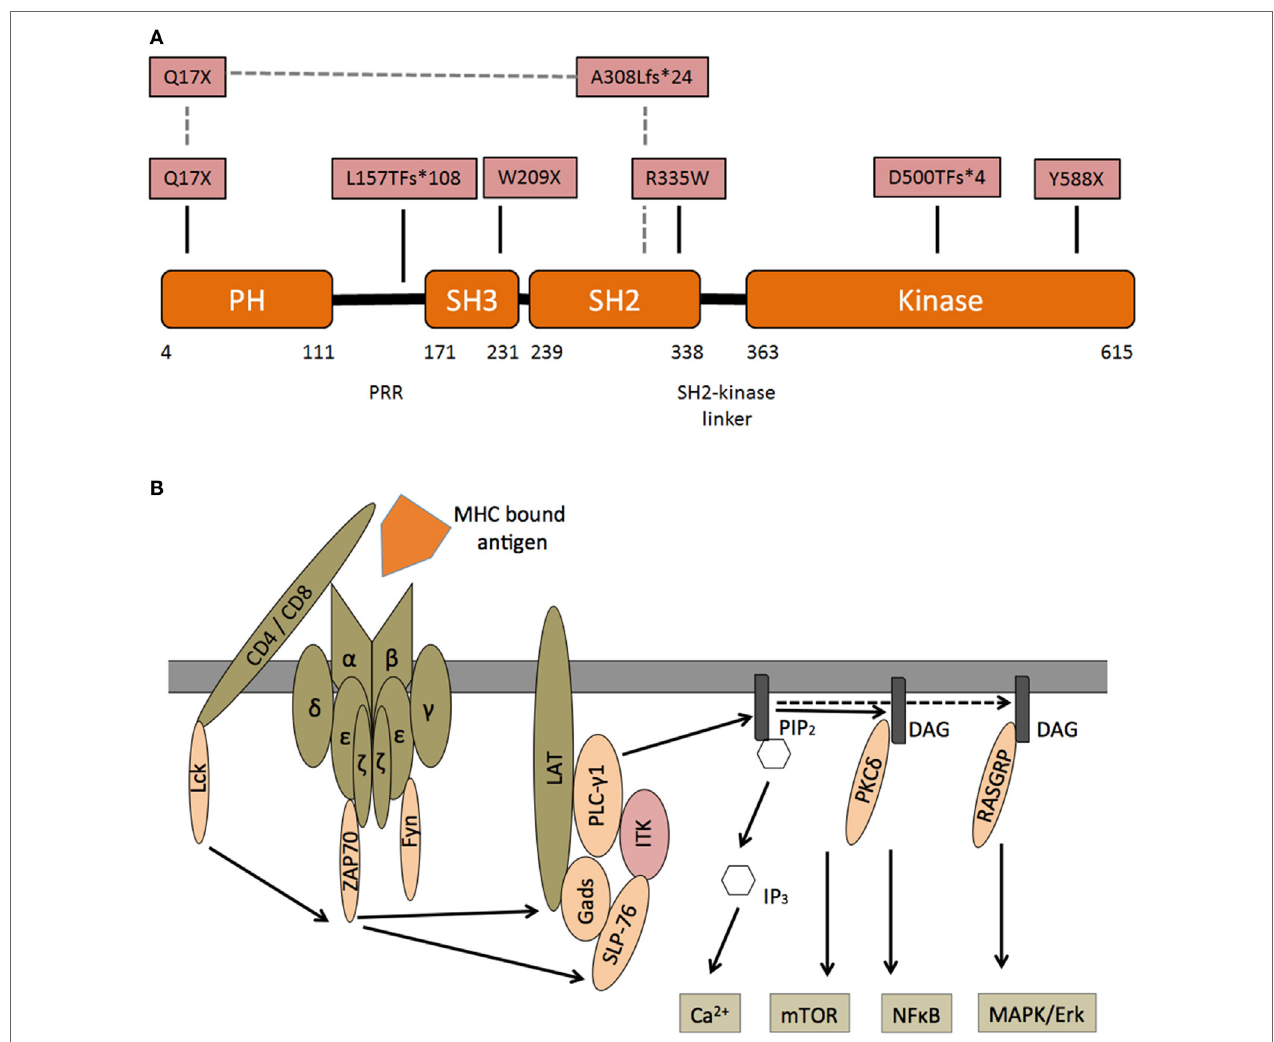
FiGUre 1 | Interleukin-2-inducible T-cell kinase (ITK)—structure and signaling— (A) domain organization of ITK and corresponding protein mutants in patients with ITK deficiency. N-terminal pleckstrin homology (PH), Tec homology, Src homology 3 (SH3), Src homology 2 (SH2), and C-terminal catalytic kinase domain. Pattern recognition receptors. In one patient, a compound heterozygous mutation is predicted to encode Q17X and A308LfS*24 mutant. (B) Following engagement of the T cell receptor (TCR) with an MHC bound foreign antigen, several intracellular signals are activated. Lck is recruited and phosphorylates immunoreceptor tyrosine- based activation motifs (ITAM) at the zeta chain of the TCR. ZAP70 binds double-phosphorylated ITAM residues and phosphorylates LAT, which is recruited to the TCR complex. Phosphorylated LAT recruits SLP76, which together with Itk, activates PLC γ 1. Subsequently phosphatidylinositol 4,5-bisphosphate (PIP2) is catalyzed into inositol 1,4,5-trisphosphate (IP3), which leads to intracellular calcium release and diacylglycerol (DAG). DAG itself can recruit PKC δ and RASGRP, which induce the NF κ B and MAPK/ERK pathways.